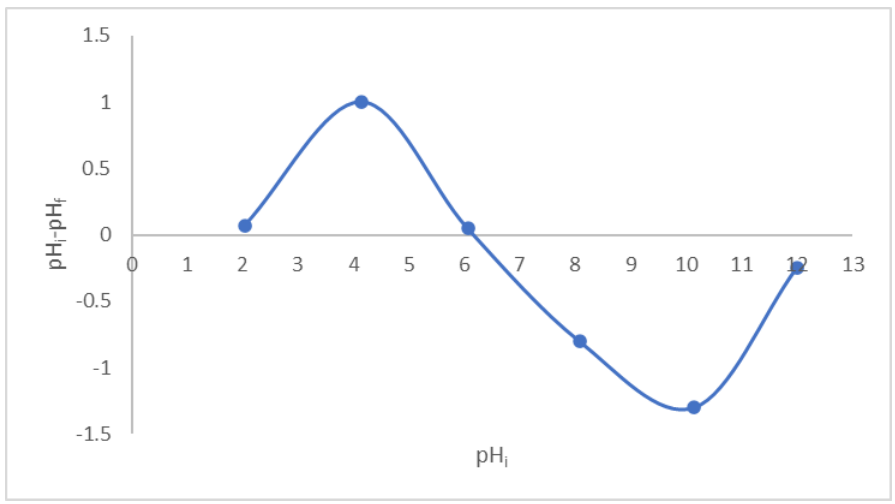
Figure 14. Point of zero charges of LCF adsorbent.